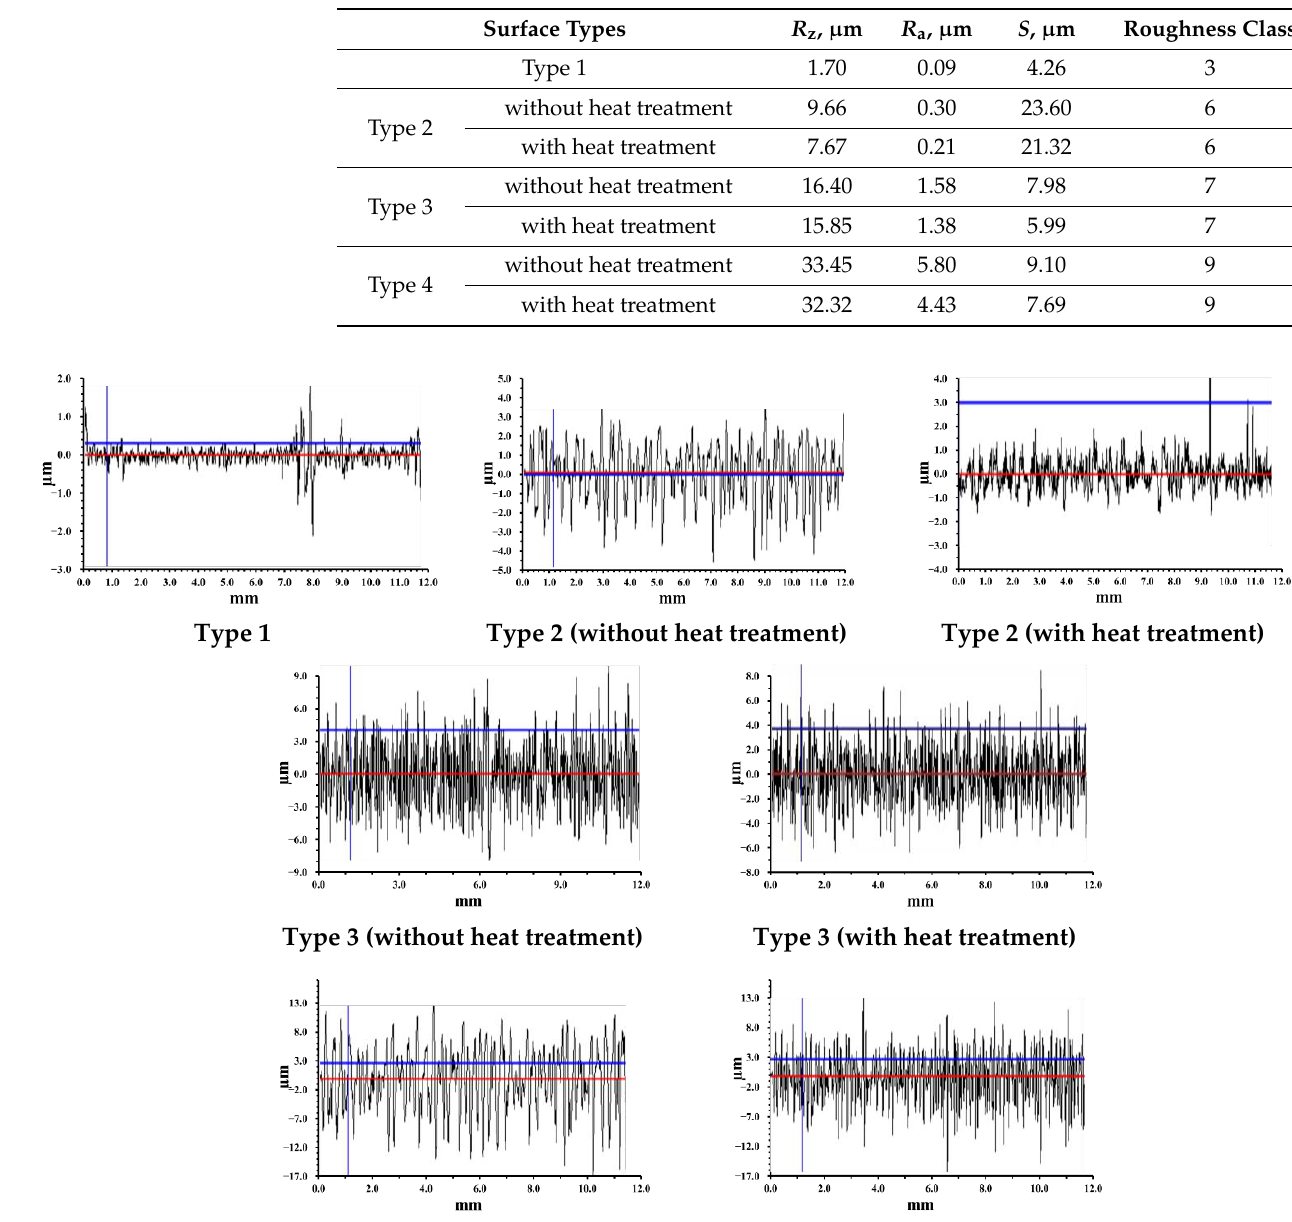
Table 1. Roughness parameters of zinc samples with different types of surface.